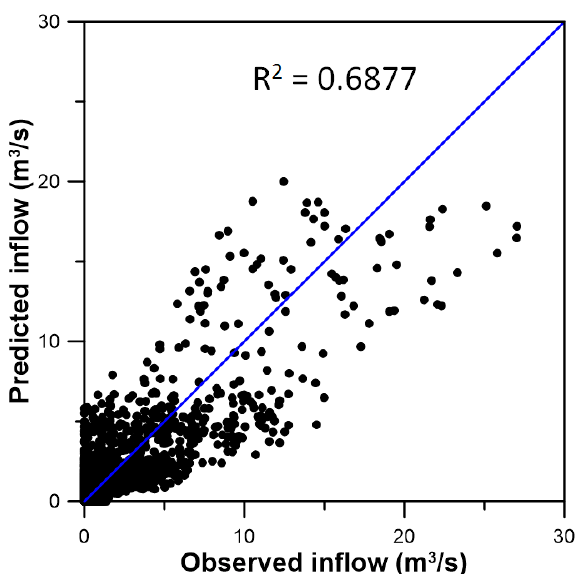
Figure 10. Comparison of R 2 for observed and predicted in fl ows when using Ftrl+IHS.